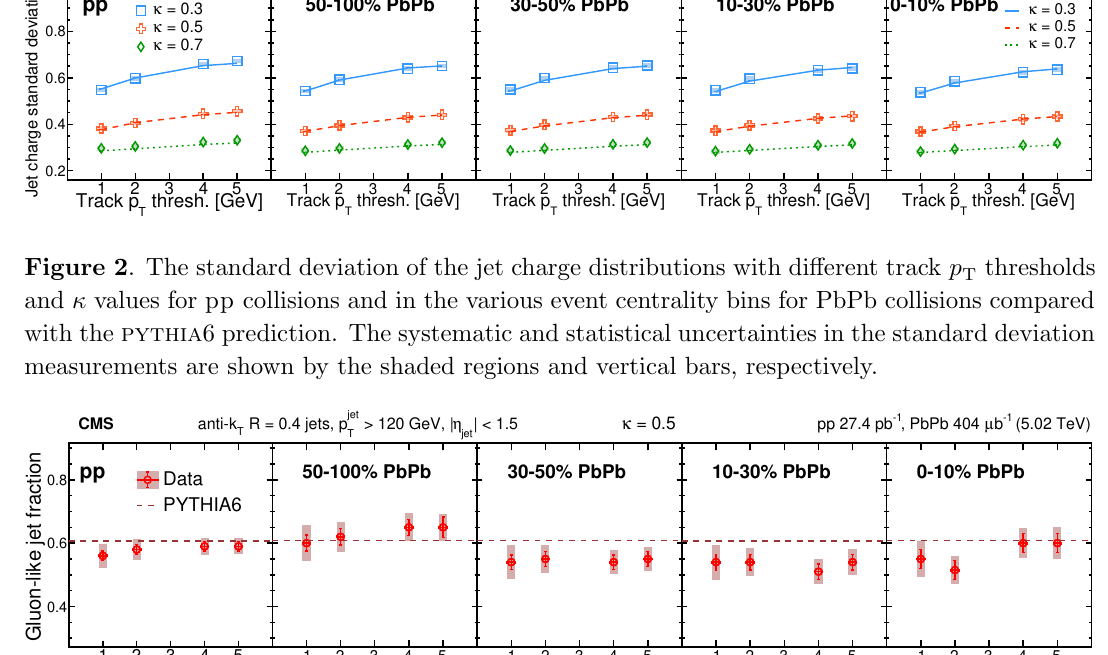
Figure 3 . Fitting results for the extraction of gluon-like jet fractions in pp and PbPb data shown for di(cid:11)erent track p threshold values and event centrality bins in PbPb collisions. The systematic T and statistical uncertainties are represented by the shaded regions and vertical bars,